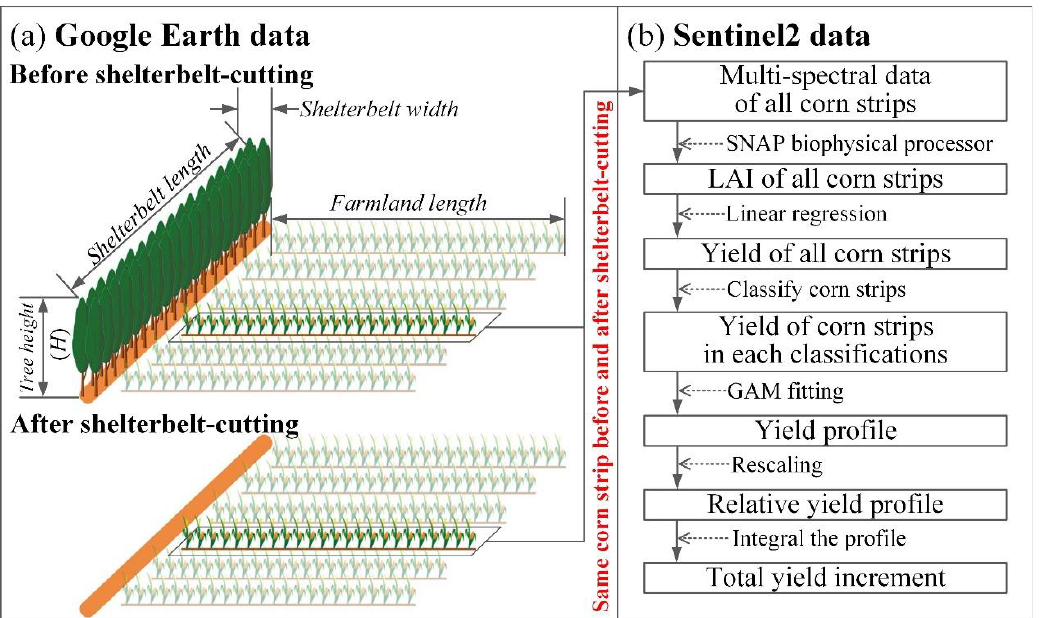
Figure 2. The schematic diagram for selecting the target shelterbelt ( a ) and the flowchart to quantify the legacy effect of post-cutting shelterbelt on crop yield ( b ). the legacy effect of post-cutting shelterbelt on crop yield ( b